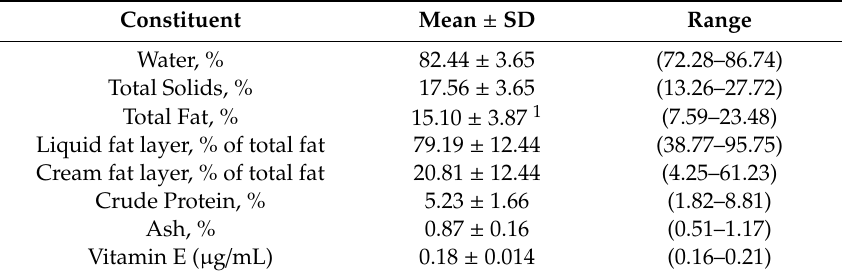
Table 3. Milk composition from six Asian elephants ( Elephas maximus ) consuming a natural diet in Myanmar sampled over an eight-month period during late lactation (17–38 months) ( n = 36 samples). Data (mean ± standard deviation (SD)) presented on a wet basis.